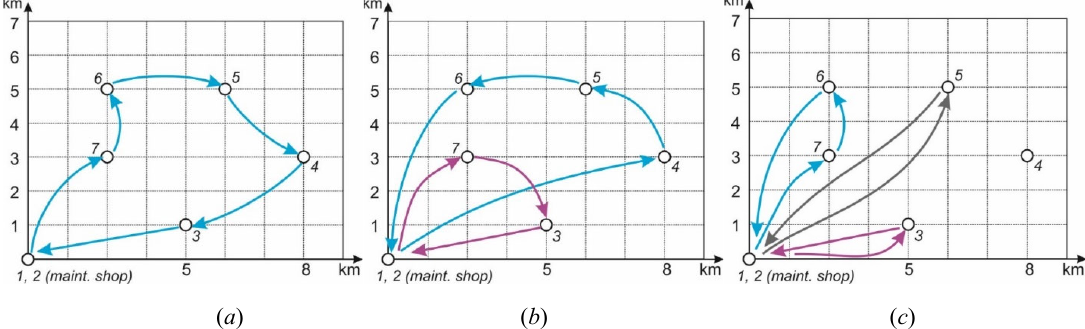
Fig. 2. a ) The routes of the optimal number of teams on the first day at a speed of 50km/hr. b ) The routes of the